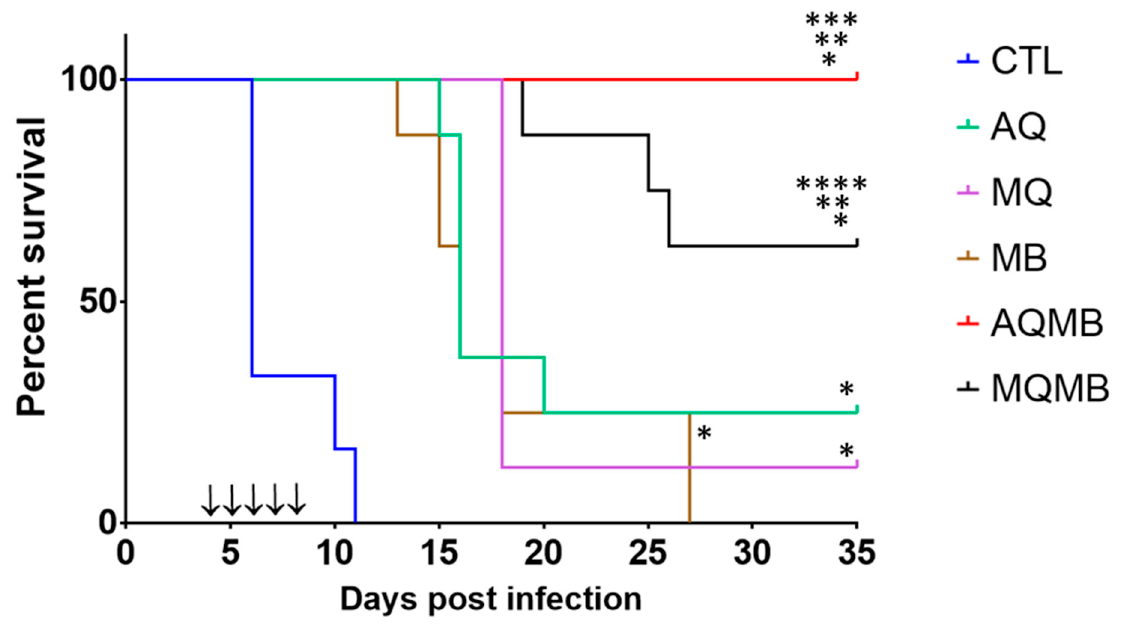
Figure 2. Survival rate for all the therapeutic groups. In blue, control (CTL) with saline solution for five days. In green, AQ 5 mg/kg for three days. In purple, MQ with 5 mg/kg for three days. In brown, MB with 10 mg/kg for five days. In red, MB with 10 mg/kg for five days associated with AQ 5 mg/kg for three days (AQMB). In black, MB with 10 mg/kg for five days associated with MQ 5 mg/kg for three days (MQMB). Black arrows indicate days of treatment. * = significant versus CTL, ** = significant versus MB, *** = significant versus AQ, **** = significant versus MQ.